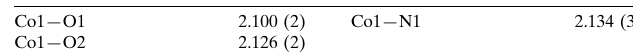
Selected geometric parameters (A˚ , (cid:2) ).